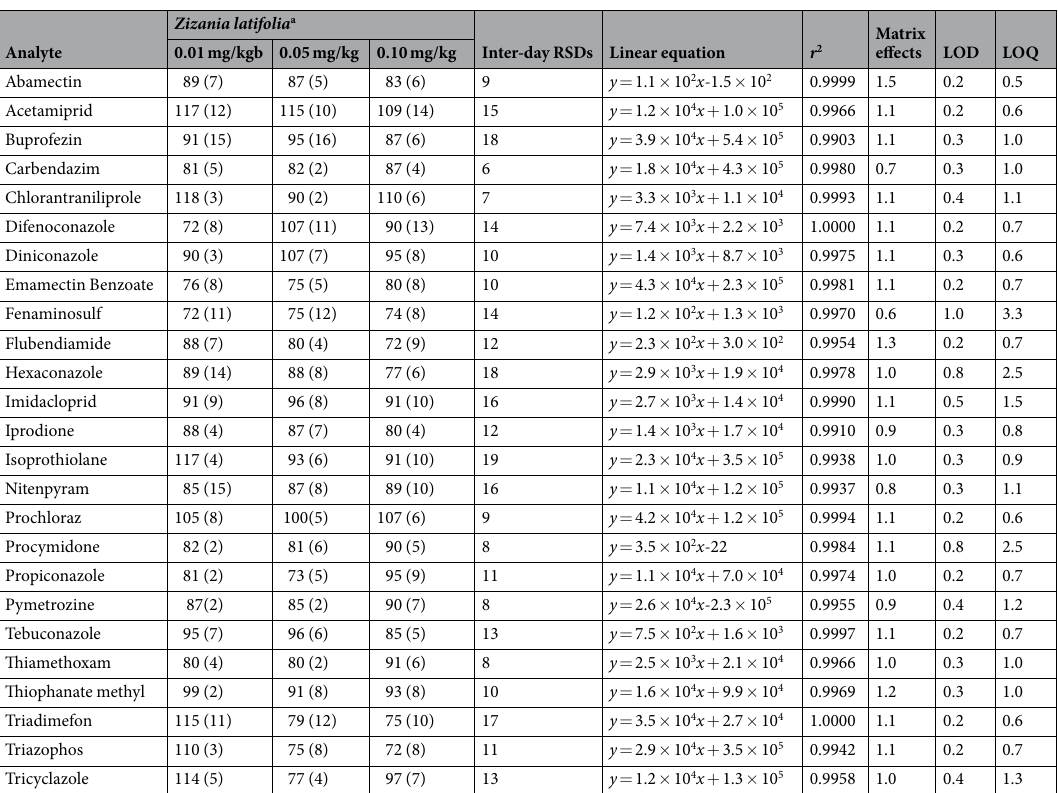
Table 2. Mean recoveries, RSDs, the linearity, regression coefficients of standard curves ( r 2 ), matrix effects, LOD and LOQ ( μ g/kg) of 25 pesticides in Zizania latifolia by LC-MS/MS. a Repeatability values, expressed as RSD, are given in brackets (n = 5). b 0.05, 0.1 and 0.25 mg/kg for fenaminosulf, procymidone and